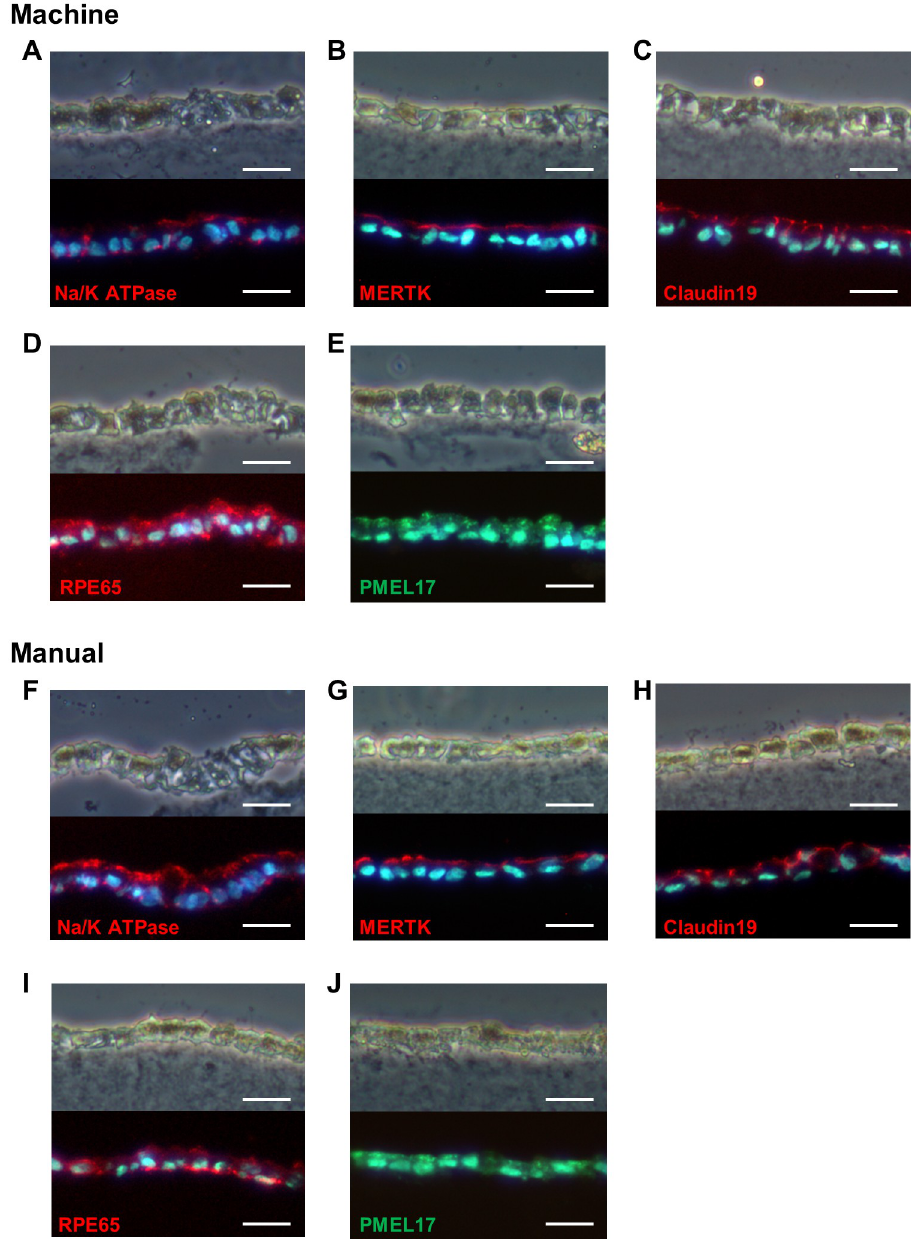
Fig 2. Phase-contrast and fluorescence images of immunostaining. hiPS-RPE cell sheets were cultured for 49 days using both machine and manual culture methods. (A–E) Phase-contrast image (top of each figure) and corresponding fluorescence image (bottom of each figure) of vertical sections of machine-cultured hiPS-RPE cell sheets. (A) Immunofluorescence detection of Na/K ATPase, (B) MERTK, (C) Claudin19, (D) RPE65, and (E) PMEL17. (F–J) Phase-contrast image (top) and corresponding fluorescence image (bottom) of vertical sections of manually cultured hiPS-RPE cell sheets. (F) Immunofluorescence detection of Na, K ATPase, (G) MERTK, (H) Claudin19, (I) RPE65, and (J) PMEL17. Nuclei were stained with DAPI. Scale bars: 20 μ